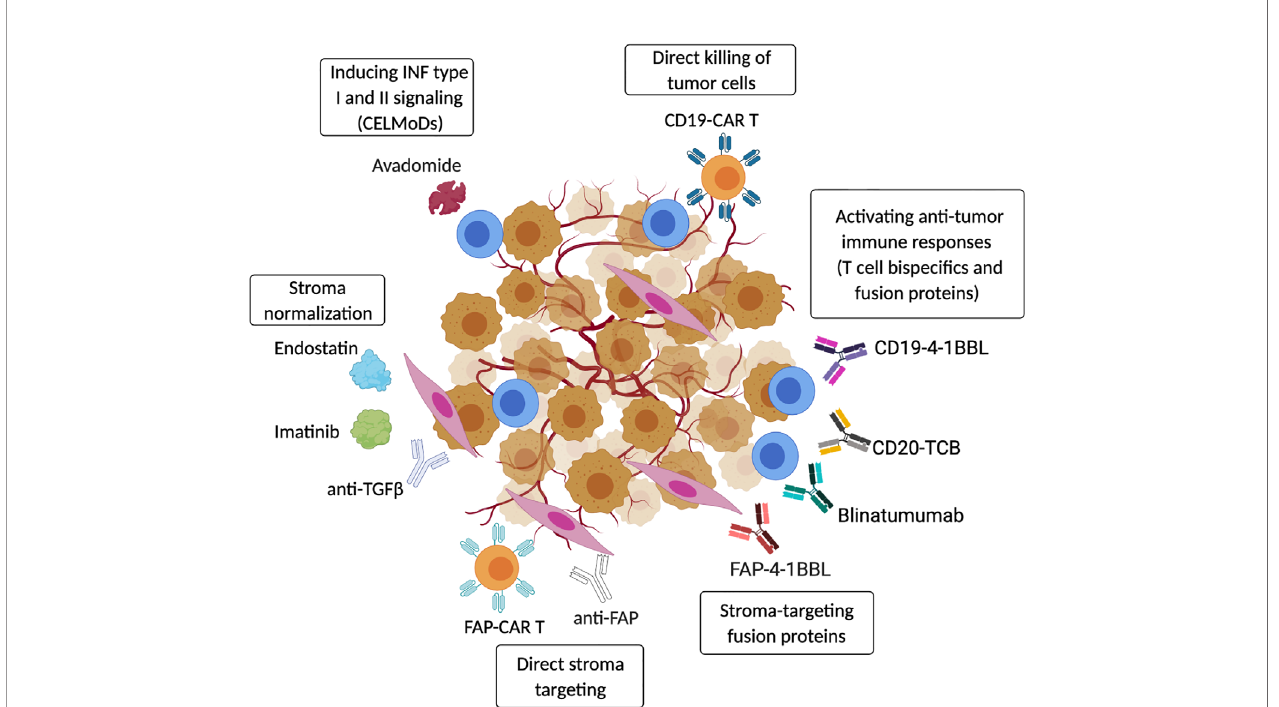
FIGURE 3 | Targeting strategies to activate anti-tumor immunity in the TME. Therapeutic strategies include re-activation of autologous anti-tumor immune responses using CELMoDs ( e.g. avadomide) (67) or T-cell bispeci fi c antibodies and fusion proteins (CD20-TCB, CD19-4-1BBL, Blinatumumab) (279 – 282). Anti-tumor immunity can also be induced by transferring CAR-T/NK effector cells that directly target cancer cells (CD19-CAR-T) (283). In addition, cancer-associated stroma can be ef fi ciently targeted to boost anti-tumor immunity, and fi broblasts-speci fi c pharmacological approaches (anti-FAP antibodies or CAR-T) have been shown to induce tumor regression (284). Tumor stroma can also be ‘ normalized ’ by blocking or neutralizing cancer-secreted factors that promote stromal cell activation (Endostatin, Imatinib, anti-TGF b ) (285 – 287). Moreover, the presence of cancer-stroma-speci fi c proteins can be used to activate tissue resident anti-tumor T cells using